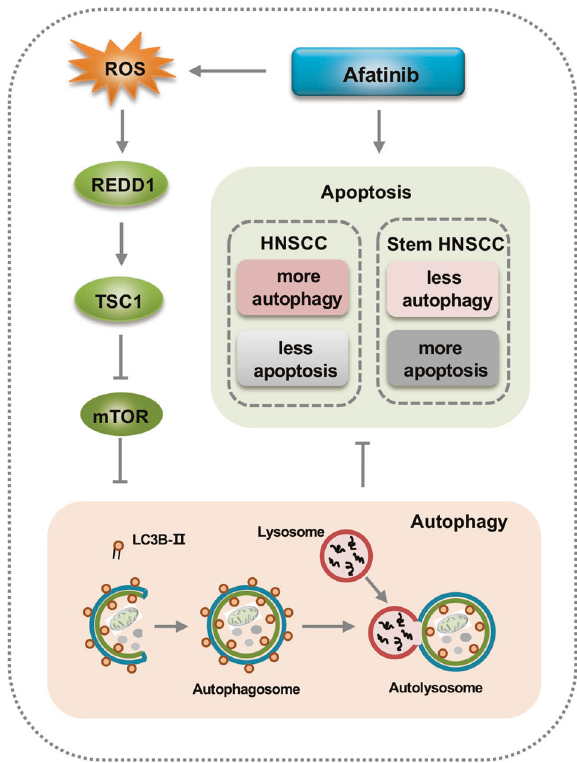
Fig. 8 Schematic illustration of the mechanism and function of afatinib-induced autophagy. Afatinib induces pro-survival autop- hagy in HNSCC via the ROS-REDD1-TSC1-mTOR axis. Importantly, afatinib preferentially eliminates cancer stem-like HNSCC cells that may attribute to weaker autophagy induction. This suggests that combined treatment with afatinib and autophagy inhibitors might serve as a promising strategy for improving the clinical outcome of afatinib in HNSCC